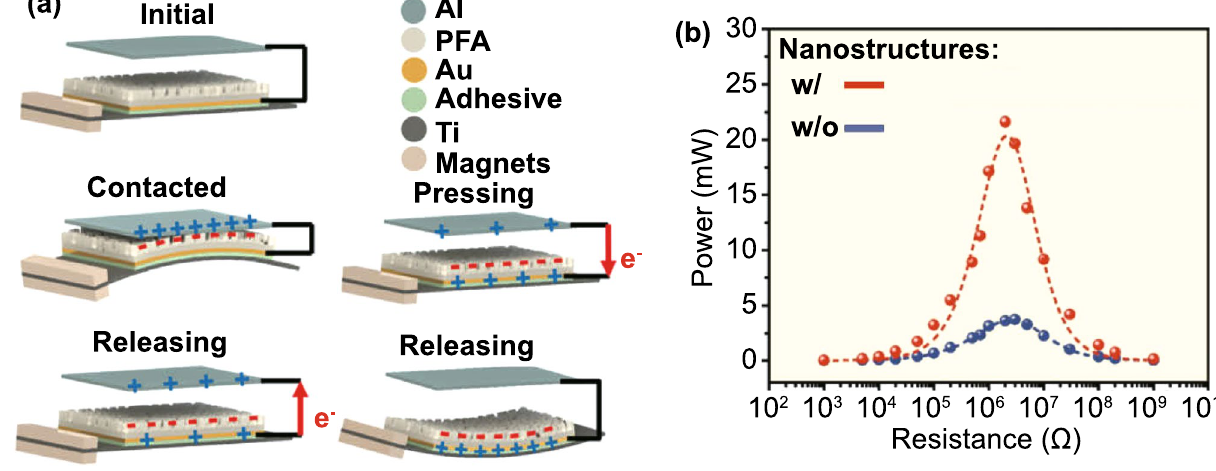
Fig. 28 a Schematic of the magneto-mechano-triboelectric generator designed by Lim et al. b Peak power measured at the resonance frequency as a function of the load resistance, with and without nanostructures in the PFA film. Adapted from Ref. [108]. (Color figure